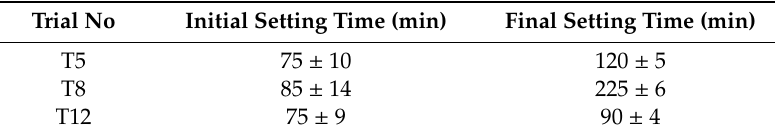
Table 5. The setting time results for the three main trials.